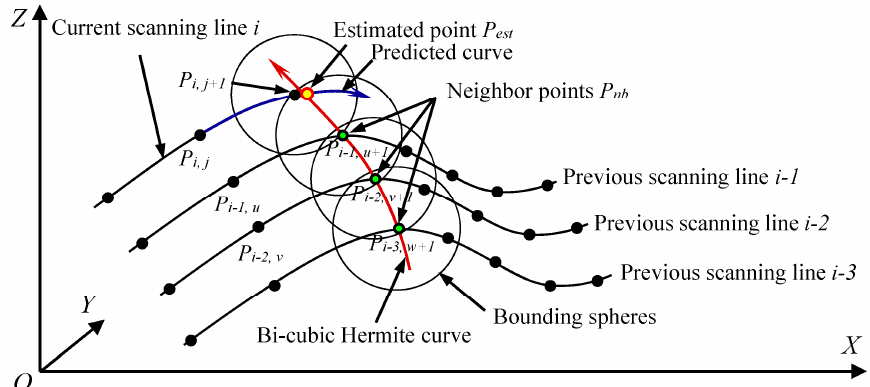
Figure 4. The schematic diagram of data redundancy identification.